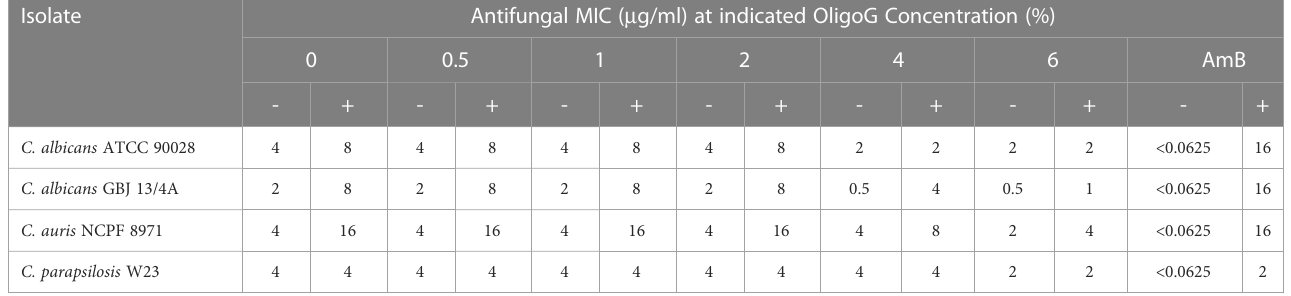
TABLE 2 MIC values (µg/ml) of the antifungal nystatin at indicated OligoG concentrations (0.5, 1, 2, 4, 6%) in the presence and absence of ergosterol (400 µg/ml) against Candida strains measured after 2 days incubation (n=3). Isolate